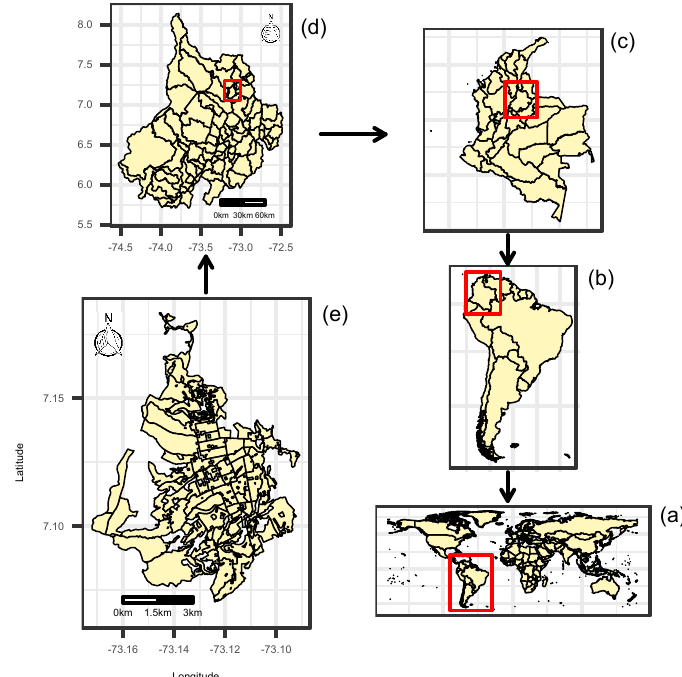
Figure 1. Geographical location of the study area: ( a ) world map; ( b ) South America; ( c ) Colombia; ( d ) department of Santander; ( e ) city of